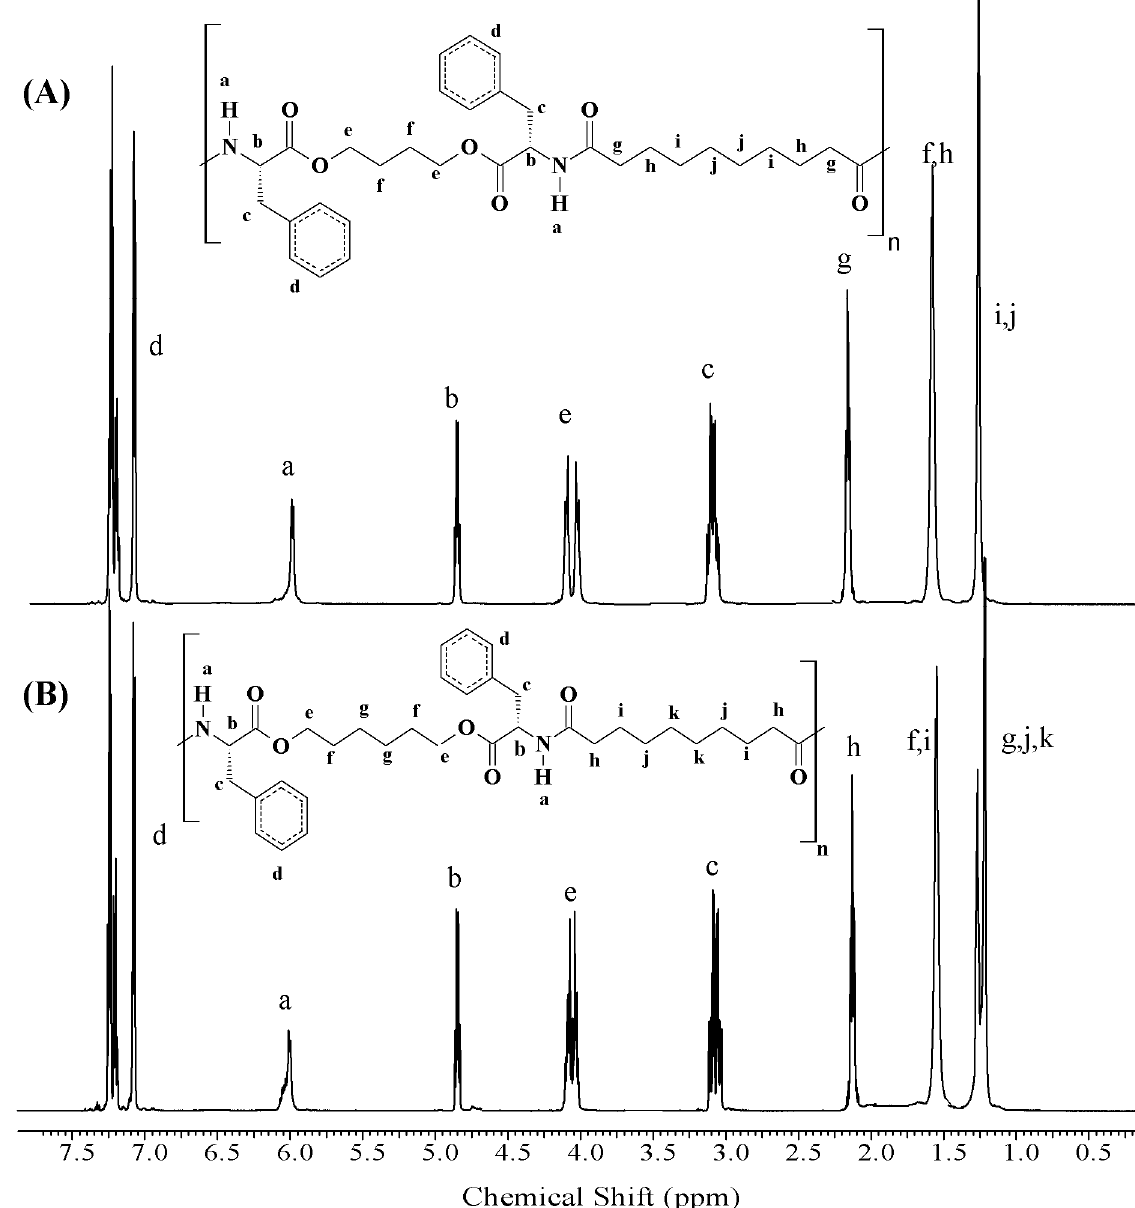
Figure 2. 1 H - NMR spectra for PEAs synthesized from L -phenylalanine. (A) PEA-Ph48 and (B)